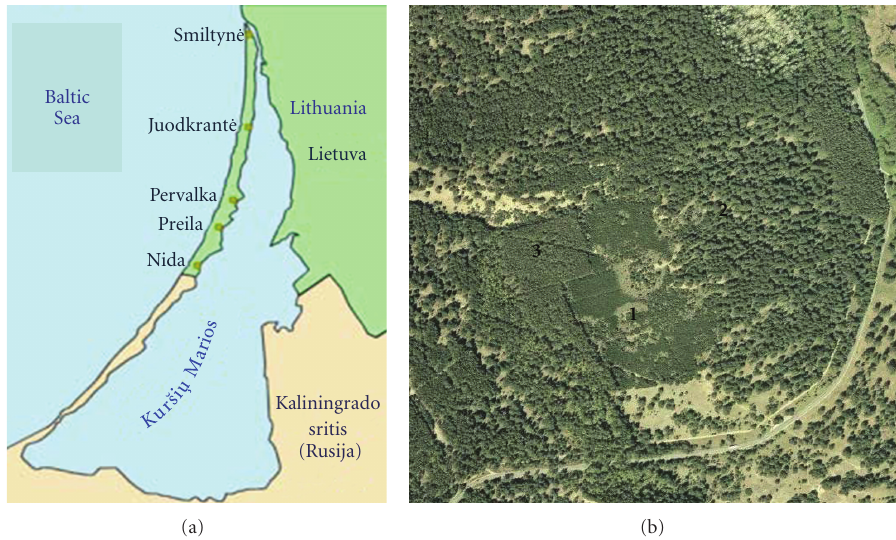
Figure 1: (a) Map of Kursiu Nerija spit in the seaside Lithuania with the sampling locations. (b) Arial photo of a sampling location “Avino Ragas” near Juodkrant˙e. P. mugo stand (1) is surrounded by naturally (2) and artificially (3) established P. sylvestris stands. The putative hybrids were sampled at the edge of the P. mugo stand. The introduced P. sylvestris may di ff er in flowering time from the local stand and so create more variation in flowering time and success of mating with P. mugo .